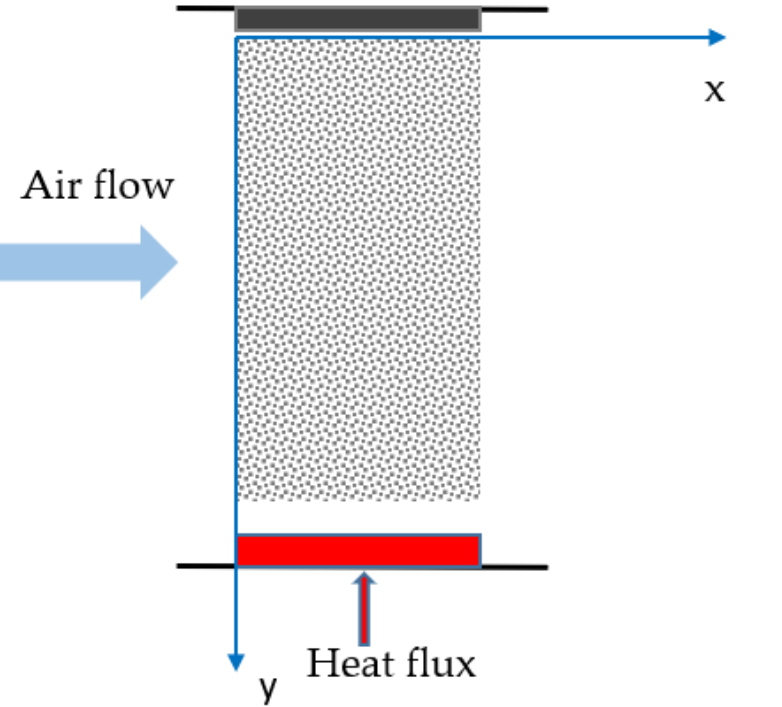
Figure 8. Experimental arrangement showing locations of the local temperature measurement and the coordinate system of [67]. The x- and y-coordinates are measured in mm. The foam block of [67] had the morphological properties shown in Table 1. Table 1. Properties of one sample of open-cell aluminum foam used by [67]. Porosit, Pore Density, ppi ε